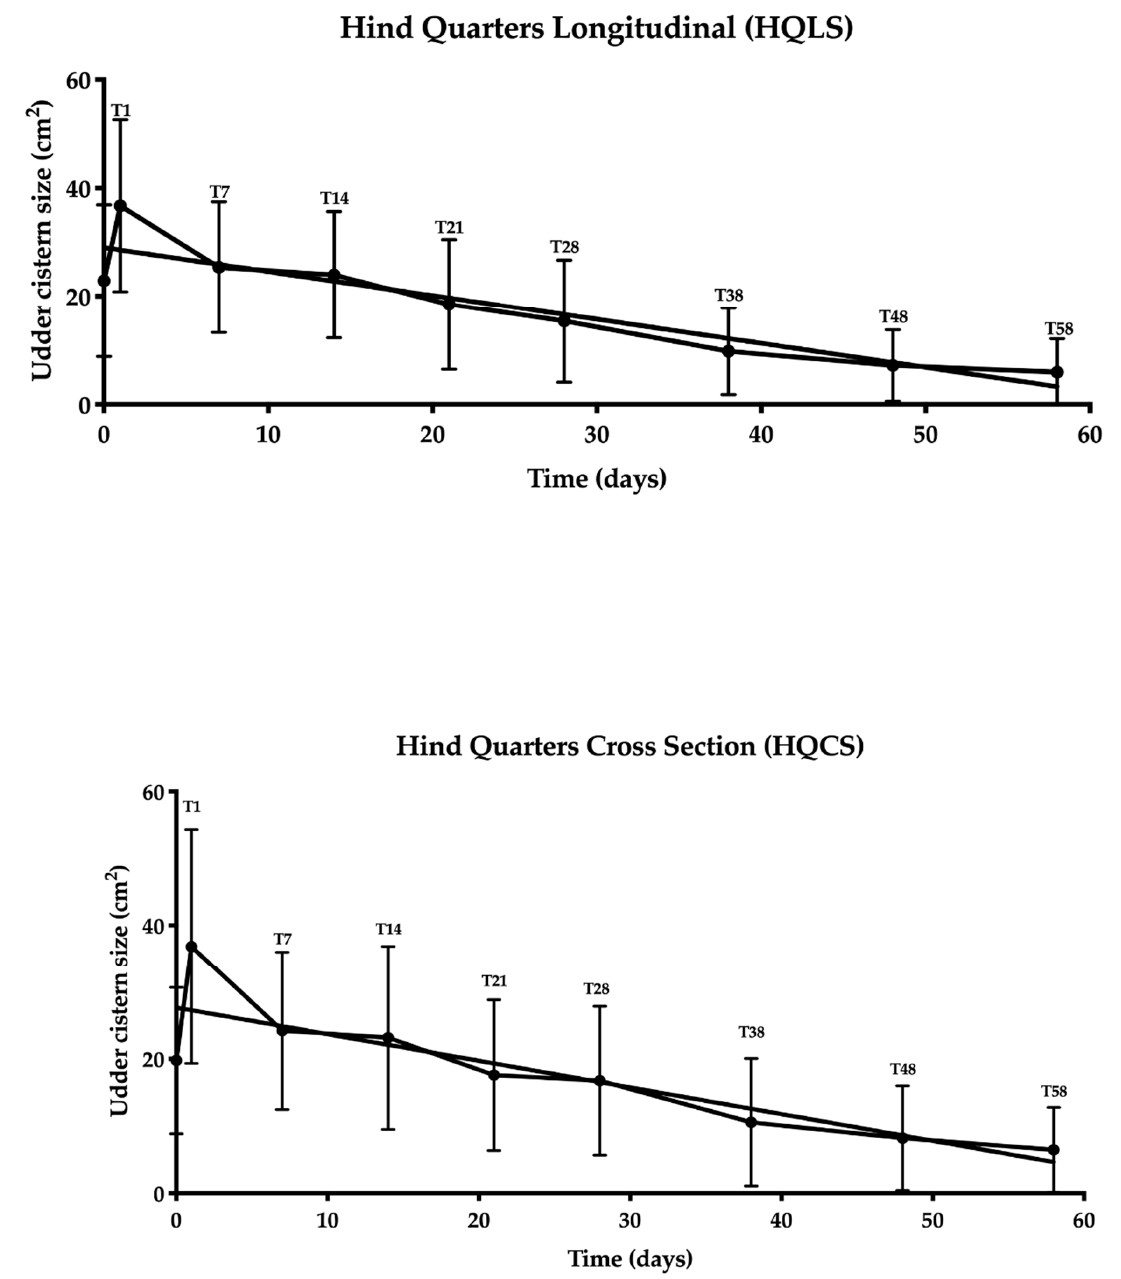
Figure 3. Correlation analysis between the udder cistern size and time (T0–T58) for hind quarters in the longitudinal and cross sections.